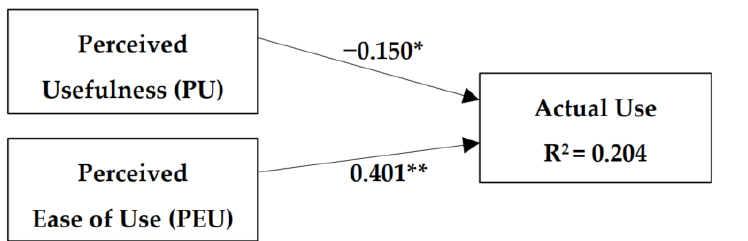
Figure 1. Model 1: The model includes perceived usefulness and perceived ease of use as independent variables. Both variables were found to be associated with individuals’ use of virtual clinics. The model explained 20.4% of the actual use of virtual clinics and the beta for both variables was significant. * p < 0.05; ** p < 0.001.